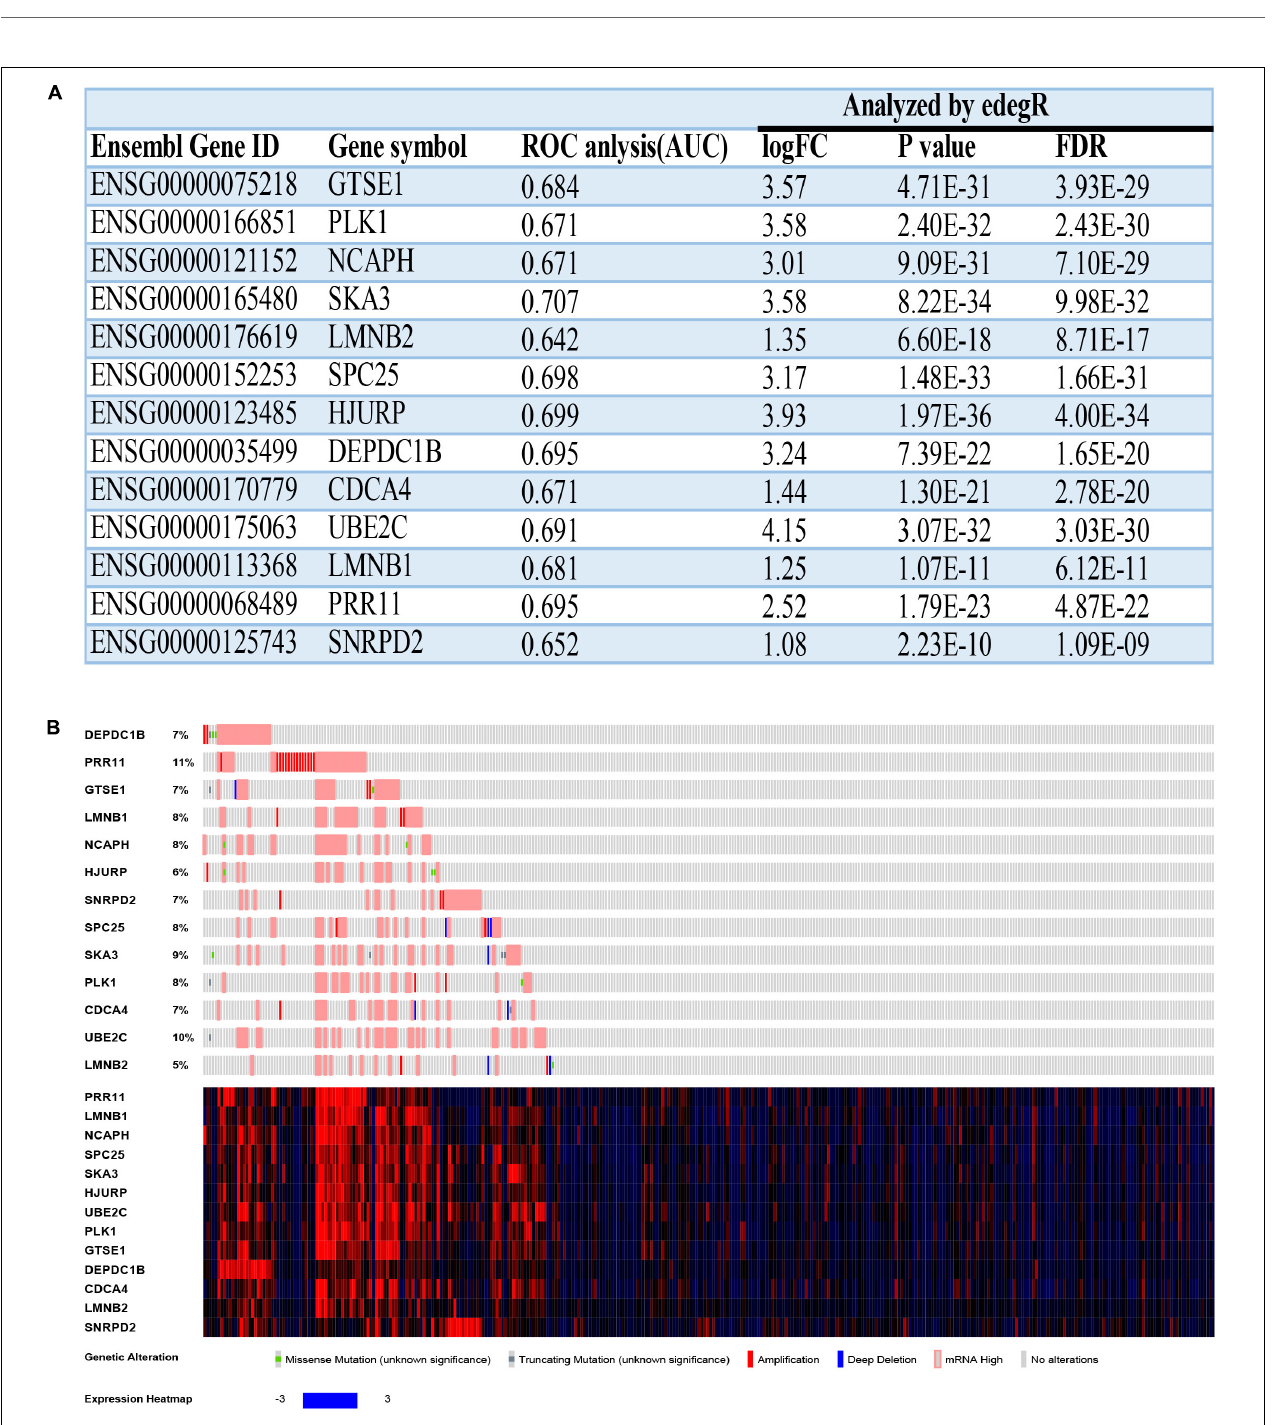
FIGURE 9 | The basal information and mutation information for 13 hub genes. (A) Information on 13 hub genes. ROC, receiver operating characteristic; AUC, area under curve; FC, fold change; FDR, false discovery rate. (B) Mutation information on 13 hub genes in the cBioPortal